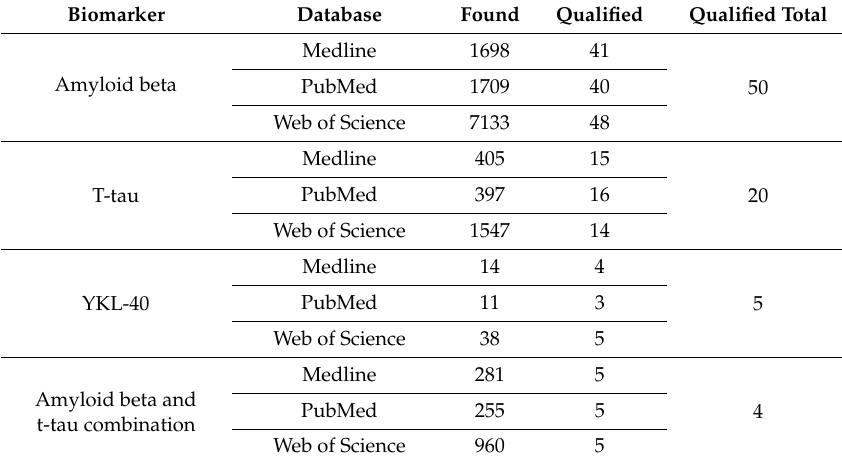
Table 1. Search results in each